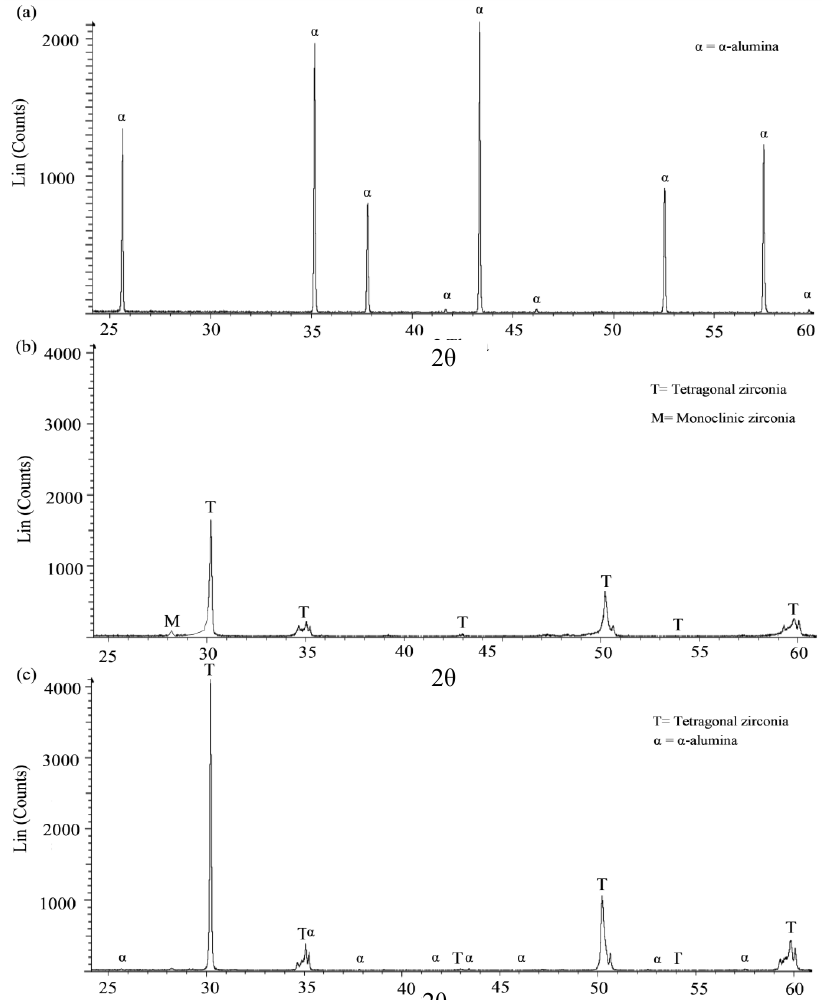
Figure 5. X-ray diffraction (XRD) patterns of the sintered ( a ) Alumina; ( b ) YSZ; and ( c ) 1 vol.% Al 2 O 3 .